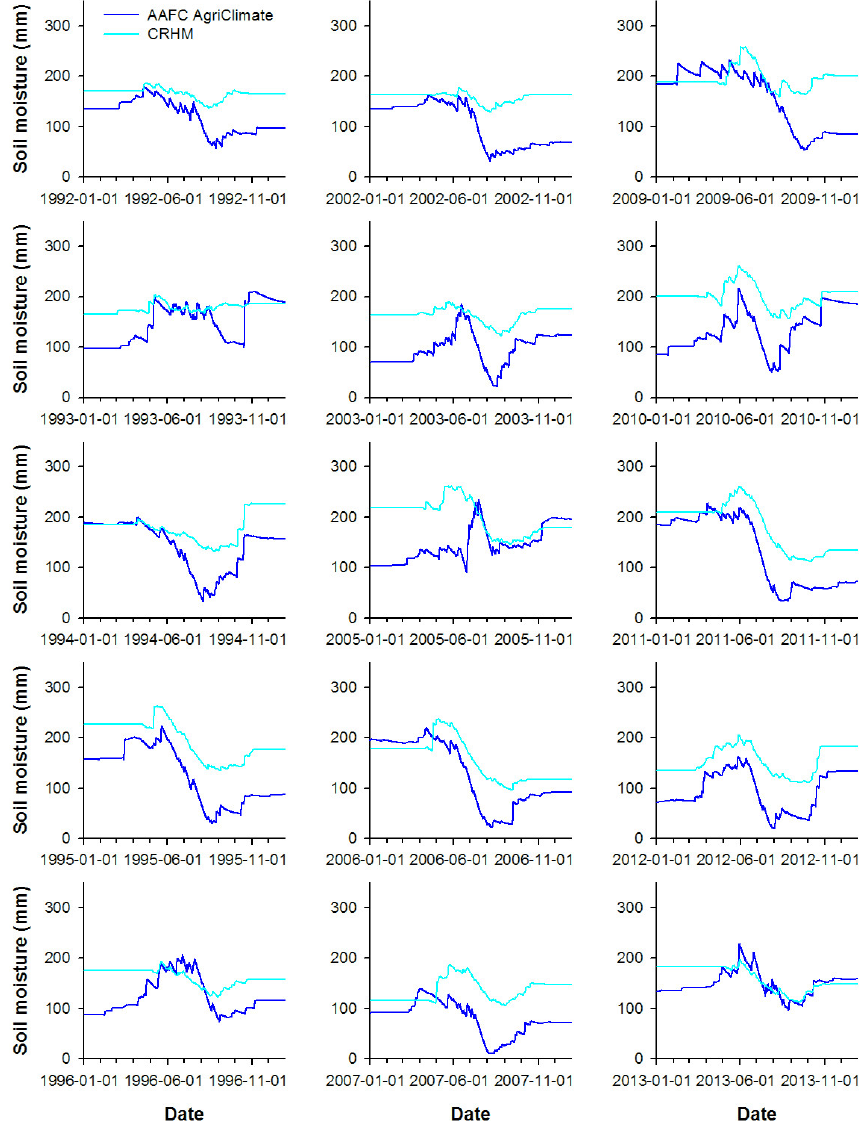
Figure 8. Comparison between simulated volumetric soil water content (VWC; expressed in mm of water in the soil profile) produced by the National Drought Model (NDM) and CRHM between 1992 and 2013 for years with good records in the HYDAT